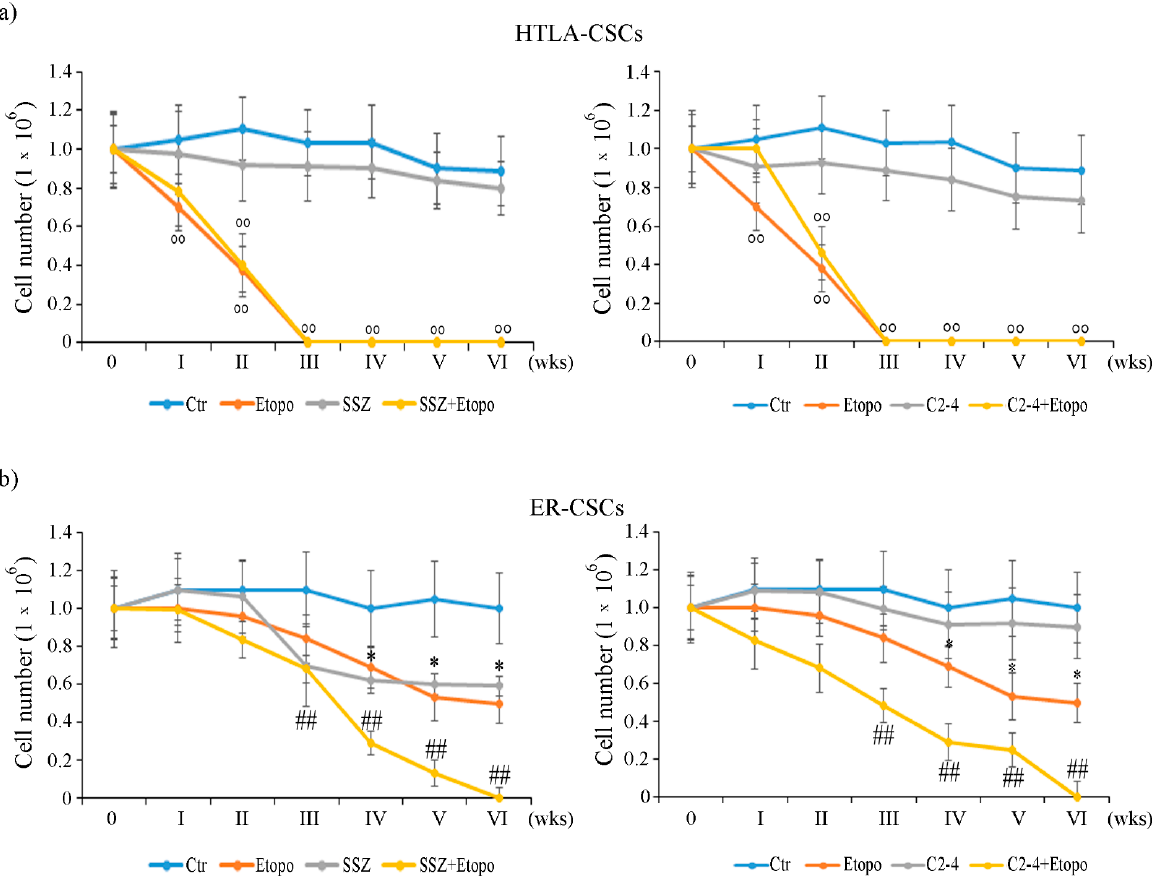
Figure 2. Evaluation of cell number in HTLA-CSCs ( a ) and ER-CSCs ( b ) treated three times a week with 0.1 µ M C2-4, with 5 µ M SSZ or with 1.25 µ M Etoposide, administered once a week alone or in combination with C2-4 or SSZ. The treatments were protracted for six weeks. In order to evaluate CSC propagation, at any split, disaggregated CSCs were counted using a Burker chamber as described in Materials and Methods. °° p < 0.01 vs. untreated HTLA-CSCs (Ctr); * p < 0.05 vs. untreated ER-CSCs (Ctr); ## p < 0.01 vs. Etoposide-treated ER-CSCs. Together these results demonstrate that ER-CSCs maintain their resistance to Etopo- side and show that ER-CSC generation is totally inhibited by co-treatments with SSZ or C2-4. Moreover, the data obtained confirm that the inhibition of xCT is a useful strategy for enhancing the effect of chemotherapy [37–42] and, although the use of SSZ is limited due to its low bioavailability, its employment has been recently considered to treat high risk NB [43]. In addition, the results obtained in C2-4-co-treated cells suggest that the in- hibition of PKC α could be a novel way to sensitize CSCs to therapy by sustaining GSH depletion. In this regard, several clinical trials (NCT00042679; NCT00003236; NCT00017407) have been carried out using Aprinocarsen, an anti-sense oligonucleotide that targets PKC α mRNA, even if, unfortunately, the results obtained are not encouraging [44]. However, a large number of studies have reported the efficacy of PKC α inhibitors in sensitizing cancer cells to chemotherapeutic drugs [45–48]. 3.3. Etoposide Induces a Marked Depletion of GSH in HTLA-CSCs after Two Weeks while the Same Effect Is not Observed in ER-CSCs until Five Weeks of Treatment Untreated HTLA-CSCs and ER-CSCs displayed comparable GSH levels (about 17.07 µEq/g and 17.37 µEq/g proteins, respectively). After two weeks of Etoposide exposure, an